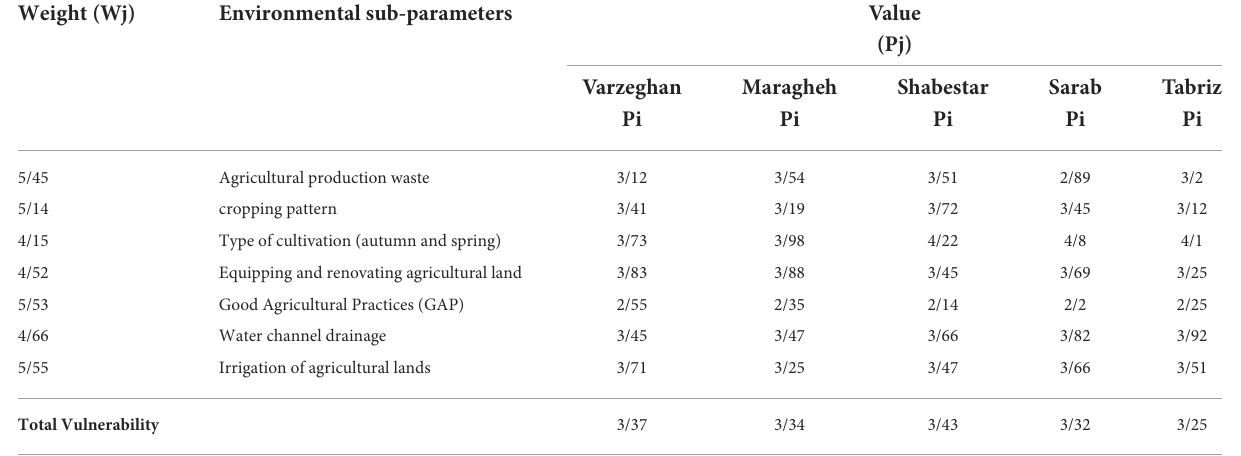
TABLE 5 The values and weights of farmers’ environmental vulnerability parameters.